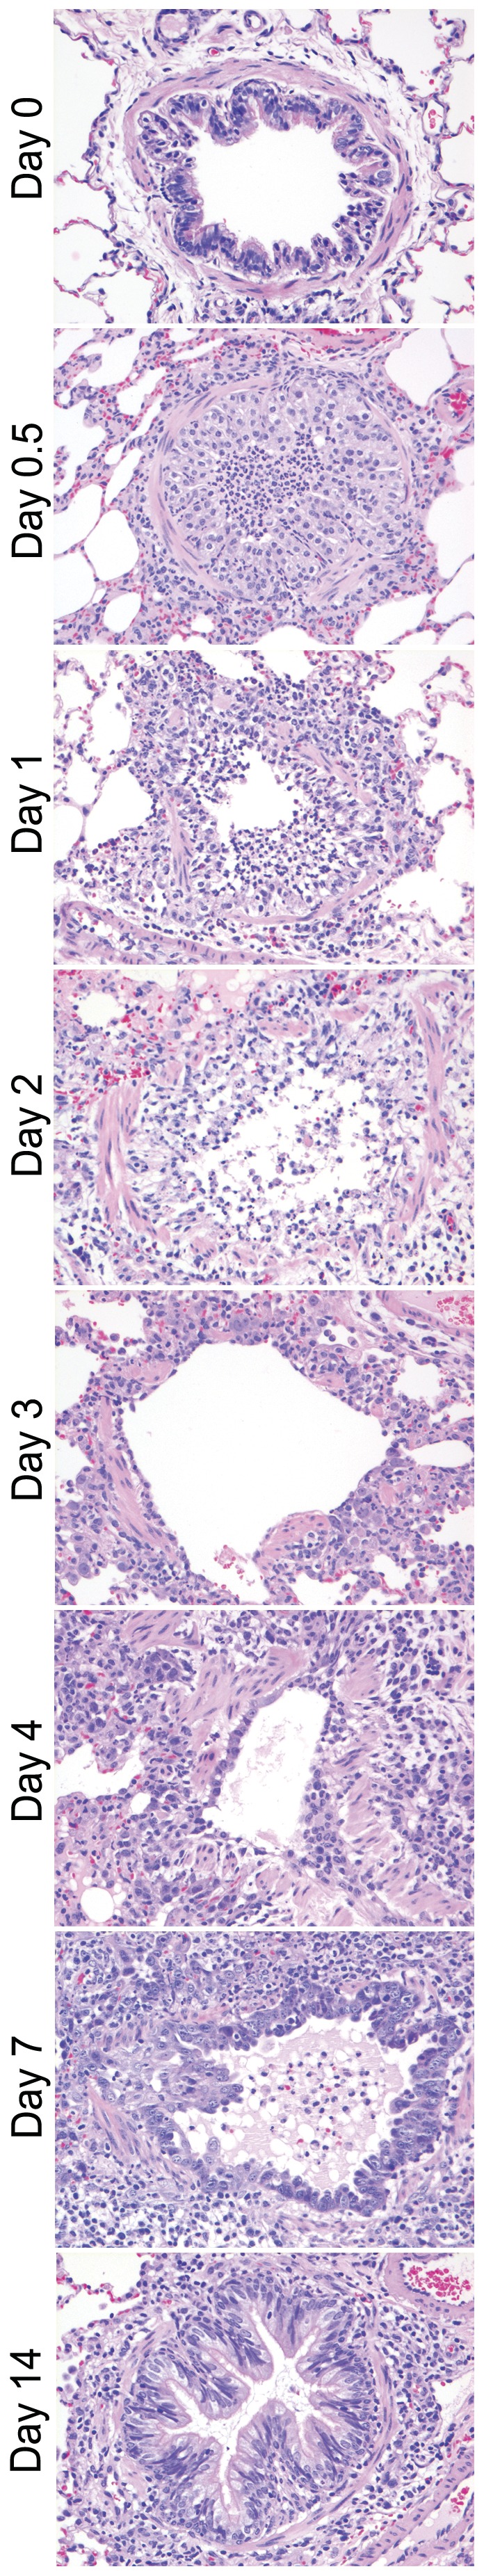
Histopathologic changes in the bronchioles during time in ferrets inoculated with pH1N1.On 0.5 dpi there was infiltration of neutrophils in the bronchiolar epithelium and lumen with mild peribronchiolar cuffing. On 1 dpi the number of neutrophils increased with necrosis of the epithelium, intraluminal cellular debris and peribronchiolar cuffing. On 2 dpi the necrosis was more severe than on 1 dpi. On 3 dpi there was denudation of the basement membrane and little regeneration of the bronchiolar epithelium with hyperplasia, peribronchiolar cuffing and occasionally cellular debris in the lumen. On 4 dpi there was increased epithelial hyperplasia with moderate cuffing. On 7 dpi the epithelium covered the basement membrane of the bronchiole with hypertrophic cells and moderate cuffing. On 14 dpi the epithelium was slightly hypertrophic with little cuffing. HE, 200×.